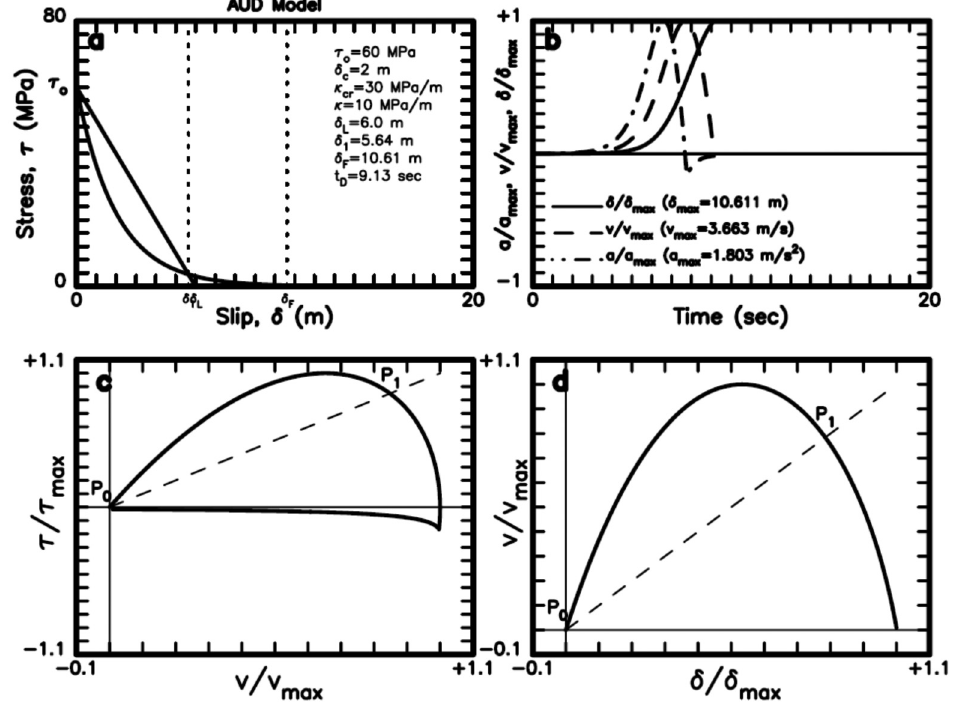
(dashed-dotted line), v/v (dashed line), max max versus v/v and two fixed points: max max versus d / d and two fixed points: P =(0,0) and max max 0